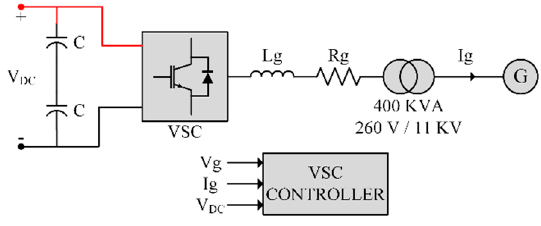
Figure 6. Overall structure of the voltage source converter (VSC).